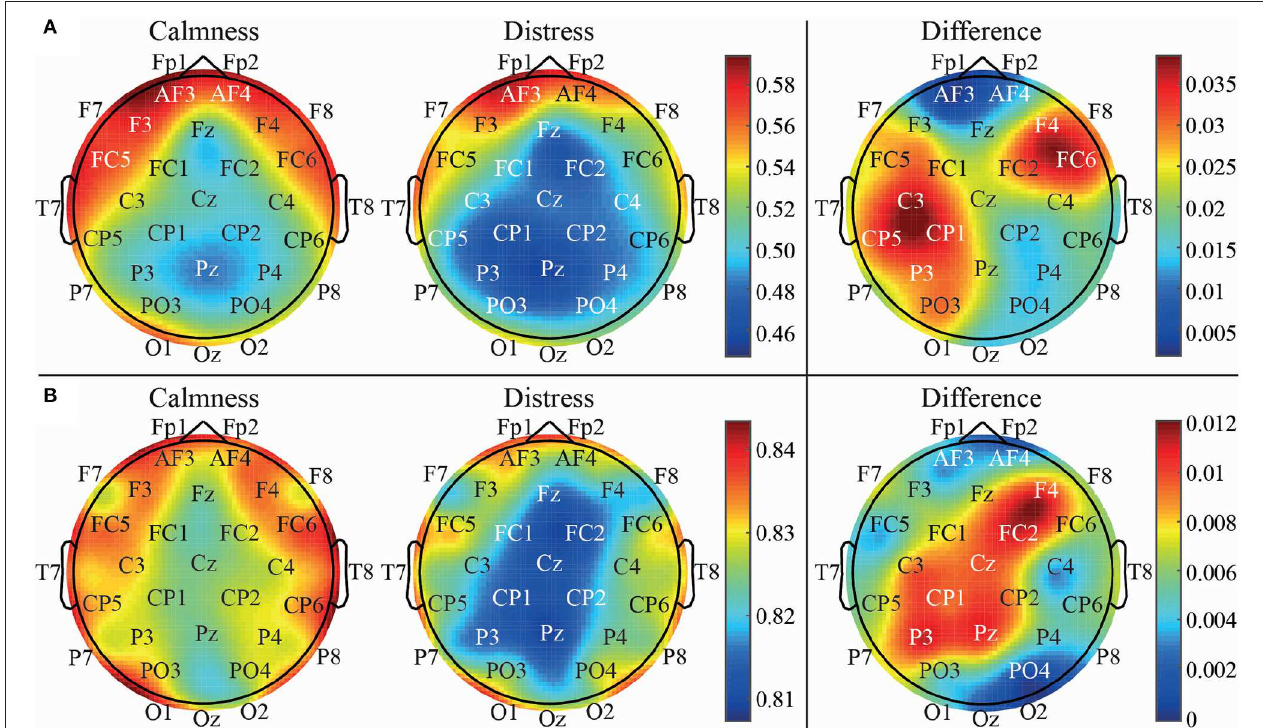
FIGURE 6 | Topological EEG representation of average calm and distressed patients for time-lag τ = 1 vs. τ = 9 using PME